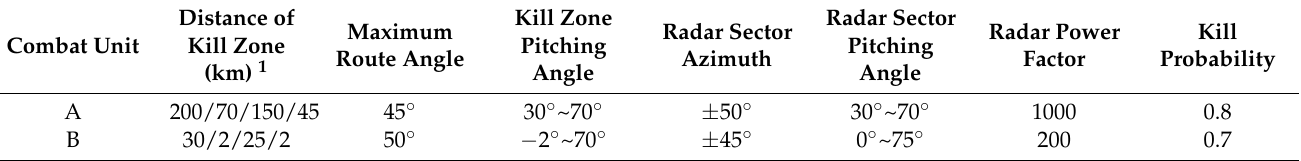
Table 3. Combat unit performance